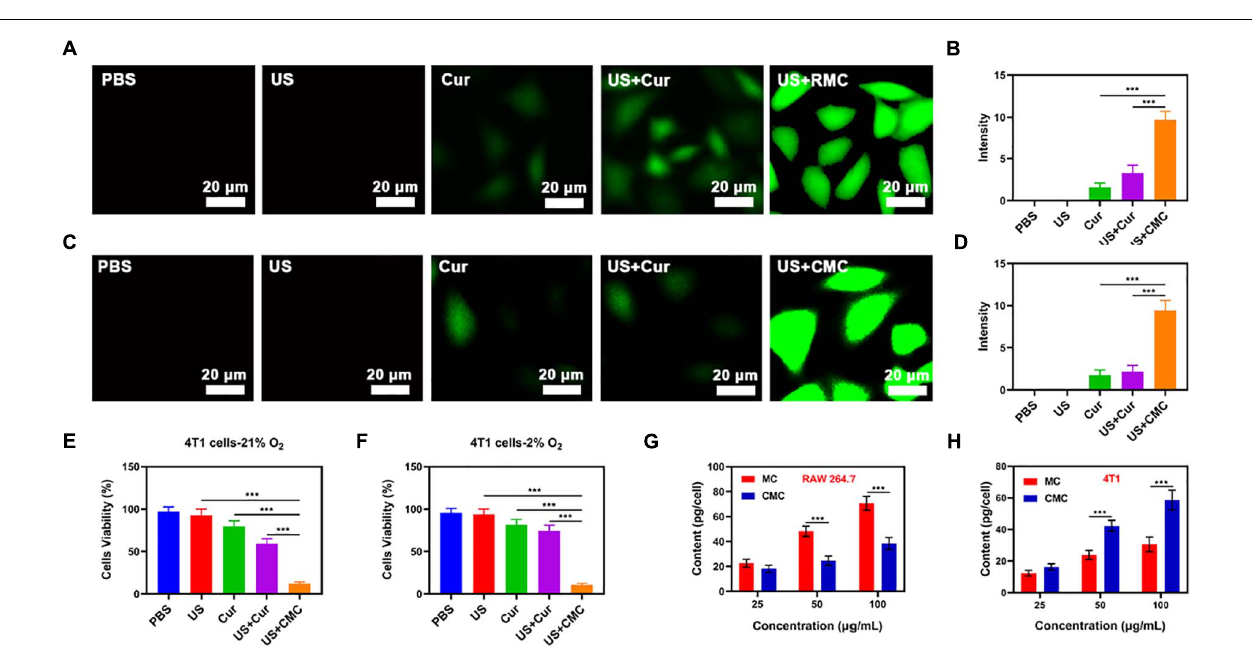
FIGURE 2 | (A) Tumor cell fluorescence images and (B) DCFH-DA fluorescence intensity following the indicated treatments under normoxia condition. (C) Tumor cell fluorescence images and (D) DCFH-DA fluorescence intensity following the indicated treatments under hypoxia condition. The survival of HepG2 cells with Control, US, Cur, US + Cur and US + CMC detected by MTT assay under (E) 21% O 2 condition or (F) 2% O 2 condition ( n = 5). (G) Nanoparticle uptake by RAW 264.7 cells at different incubated concentration (MnO 2 dose of 25, 50, and 100 µ g/mL). (H) Nanoparticle uptake by HepG2 cells at different concentration. (MnO 2 dose of 25, 50, and 100 µ g/mL). Significance between every two groups was calculated by the Student’s t -test. *** P <